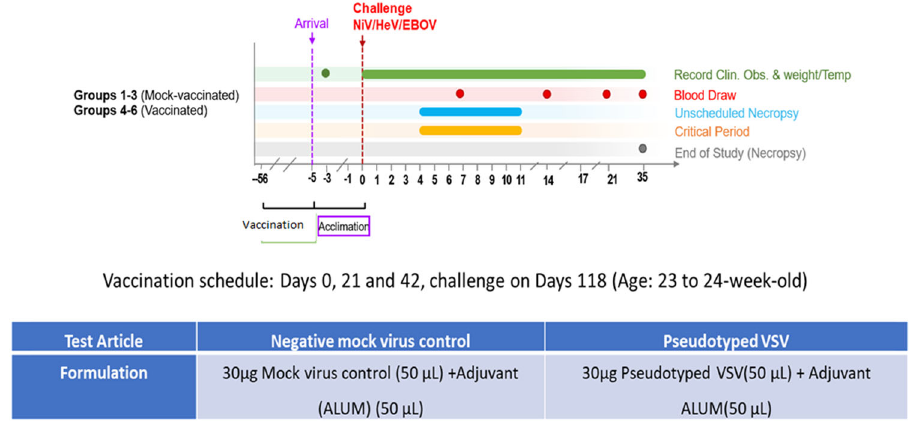
Fig. 8 The study design. The fi gure indicates the vaccination schedule for all hamsters used in this study, the amounts of mock and test vaccines applied, the point of challenge, and the period that the challenge experiment challenge hamsters for histopathology. Tissues used for analysis included the brain, liver, and lung. Figure 10A, C demonstrates presence of pathology in the brain and lung, respectively, for mock-vaccinated and NiV challenged hamsters, but not for the multivalent pseudotyped VSV vaccinated and NiV challenged hamsters (Fig. 10B, D). Pathology and results due to NiV challenge were similar to those caused by HeV challenge. Figure 10E, G demonstrates pathology in the liver and lung, respectively, in the mock vaccinated and EBOV challenged hamsters. The multivalent pseudotyped VSV vaccinated and EBOV challenged hamsters did not present pathology (Fig. 10F, H).